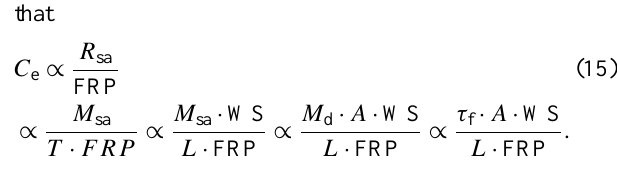
Figure 8. (a) The gap-filled, combined Terra and Aqua, global 1 ◦ × 1 ◦ coefficient of emission ( C e ) product along with (b) the corresponding quality assurance (QA) map and (c) the coefficient of determination ( r 2 ) map. These products were based on MODIS 2003–2010 observations of FRP and AOT from Terra and Aqua.